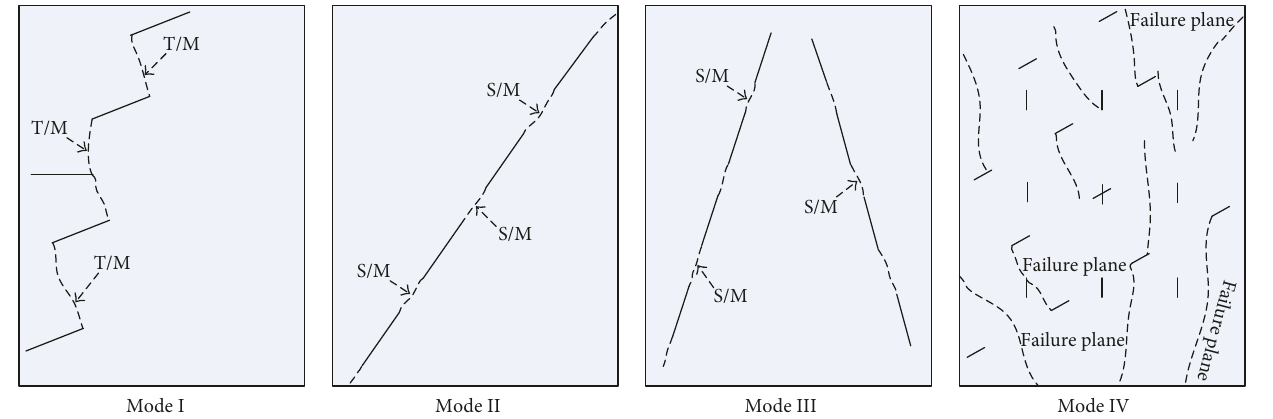
Figure 11: Failure plane in different failure